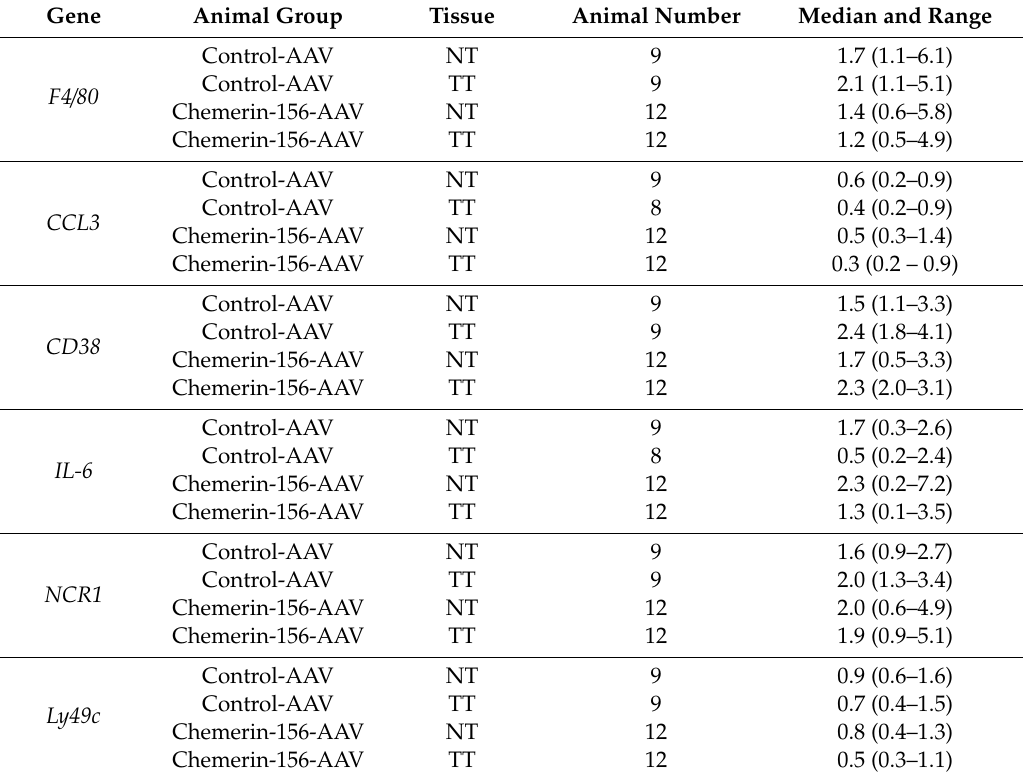
Table 1. Genes highly expressed in macrophages or natural killer cells were analyzed by real-time RT-PCR in the normal tissues (NT) and the tumor tissues (TT) of control-AAV and chemerin-156-AAV infected mice. Expression was not changed in either the tumors nor by chemerin-156 overexpression. Expression of CCL3 and IL-6 was not detected in tumor tissue of one mouse (most likely because of technical problems) and these values were not included in the